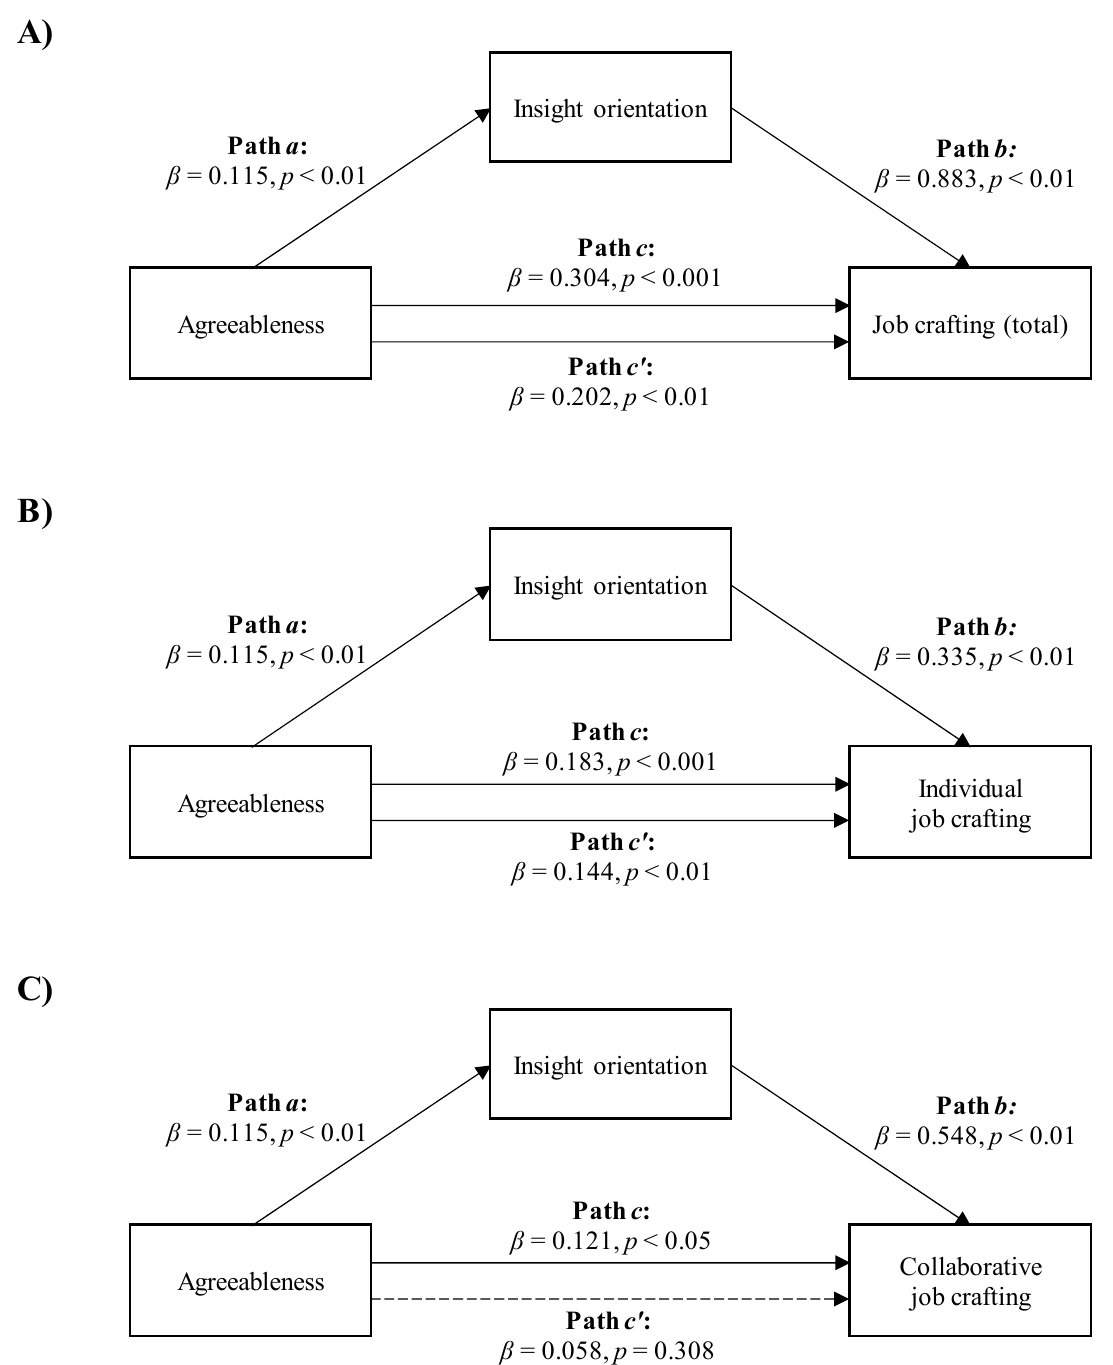
Figure 2. The mediation of insight orientation in the relationships between agreeableness and total job crafting score. ( A ) R 2 mediator effect size = 0.09, ( p < 0.05), individual job crafting ( B ) R 2 mediator effect size = 0.06, ( p < 0.05) or collaborative job crafting, ( C ) R 2 mediator effect size = 0.09, ( p < 0.05).